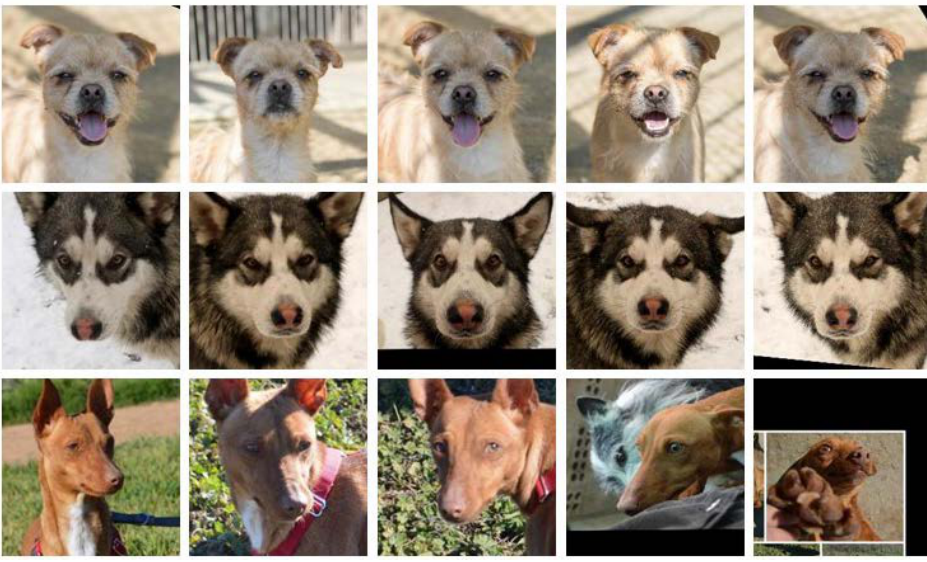
Figure 7. An example of the dog face dataset.